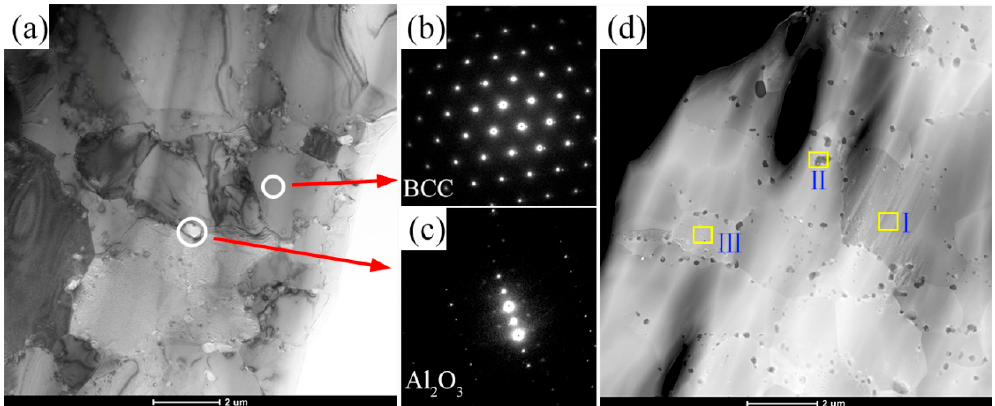
Figure 7. TEM images of NiAl composite reinforced with 10 wt.% HEA: ( a ) microstructure of 10 wt.% HEA, ( b , c ) SAD patterns of solid solution with the BCC structure and Al 2 O 3 from ( a ), ( d ) STEM image. Table 1. Chemical composition of different areas in the sample of 0 wt.% HEA and 10 wt.% HEA. Sample